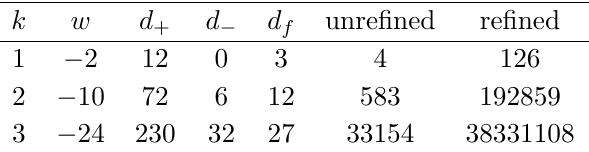
Table 10 . Numbers of possible terms in the numerator of the elliptic genus of k strings for G = A